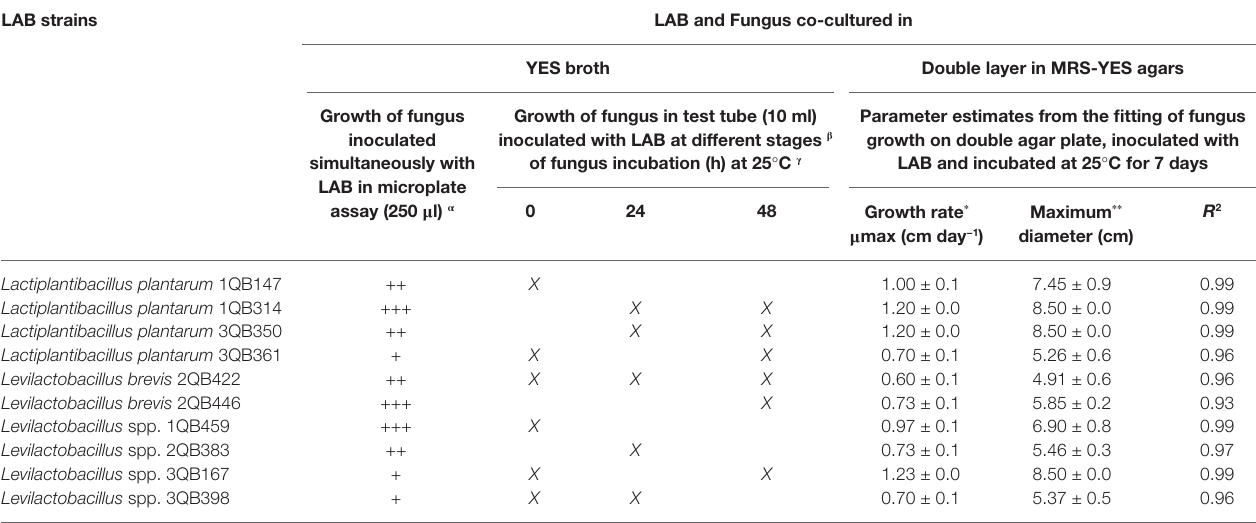
TABLE 3 | Effect of LAB on the growth of mycotoxigenic Aspergillus parasiticus NRRL 2999, investigated in yeast extract sucrose (YES) broth and double layer agar plates with de Man Rogosa and Sharpe (MRS) and YES agars. LAB